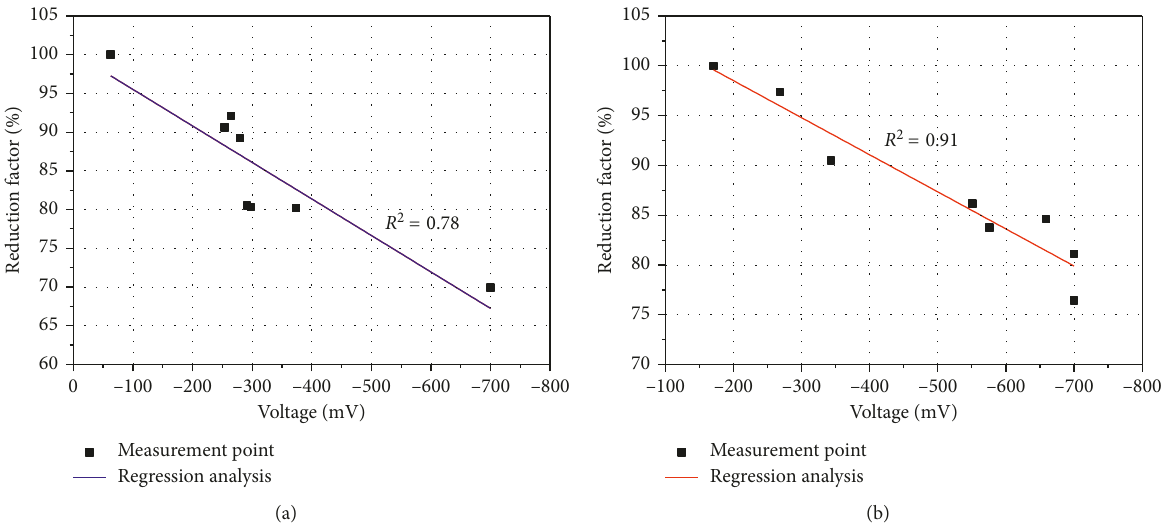
Figure 13: Relationship between the performance degradation factor and average potential difference in terms of voltage: (a) flexural failure type beams and (b) shear failure type